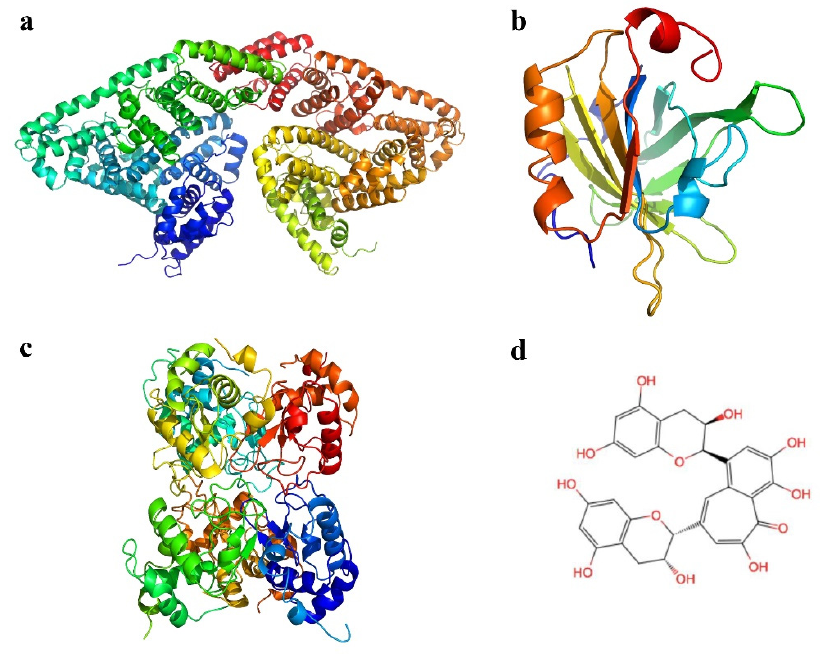
Figure 1. Tertiary structure of BSA ( a ), β -Lg ( b ), α -La ( c ) and chemical structure of theaflavin ( d ). Bovine whey protein accounts for approximately 20% of total milk protein, it is a recycled by-product of the cheese production process and is nutritionally rich but relatively affordable [15]. The bovine whey protein is compact globular proteins isolated from milk using advanced extraction methods, mainly including β -lactoglobulin ( β -Lg), α - lactoalbumin ( α -La), lactoferrin, bovine serum albumin (BSA), immunoglobulin and growth factor. Whey protein’s distinct amino acid sequence and three-dimensional structure confer diverse functional properties [16]. Due to its high bioavailability, whey protein is widely utilized in the food industries as an emulsifier for encapsulating active functional ingredients [17–19]. BSA has a molecular mass of 66.3 kDa and accounts for around 5% of whey protein. It can bind a wide range of intrinsic and extrinsic substances. Additionally,